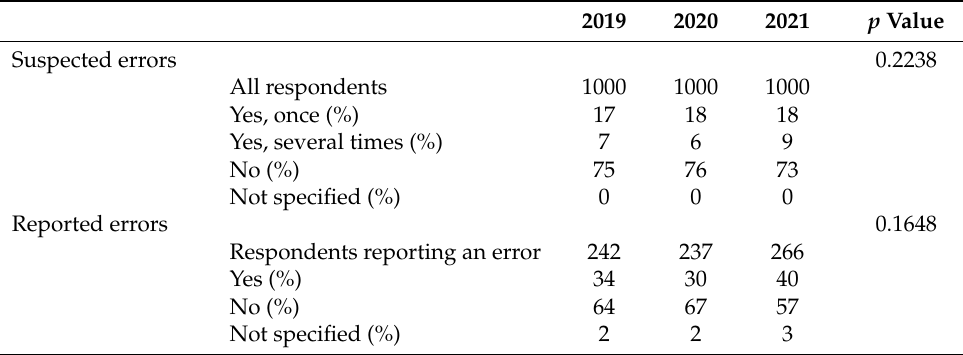
Table 4. Suspected and reported errors, 2019 to